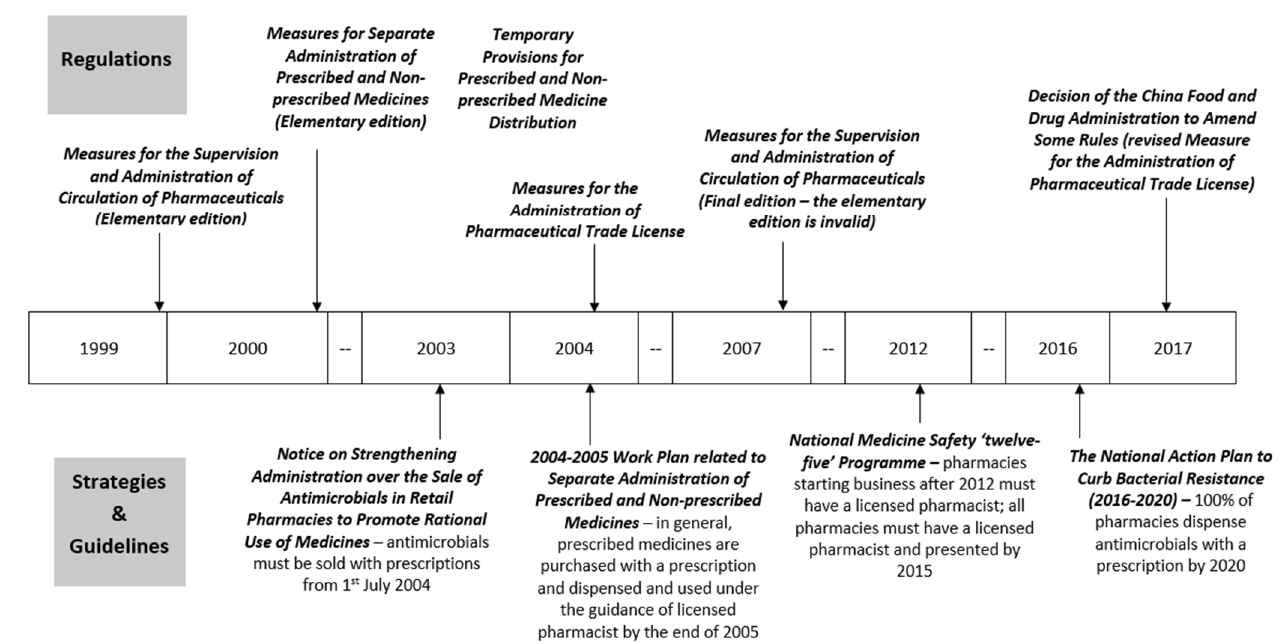
Figure 1. Timeline of key policies related to antibiotic sales in retail pharmacies in China.